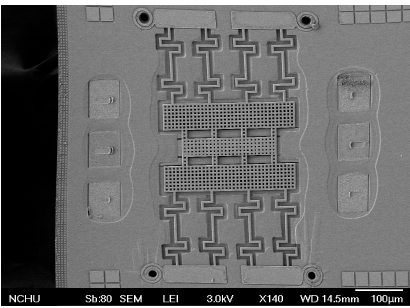
Figure 9. Scanning electron microscope (SEM) image of the micromachined switch.